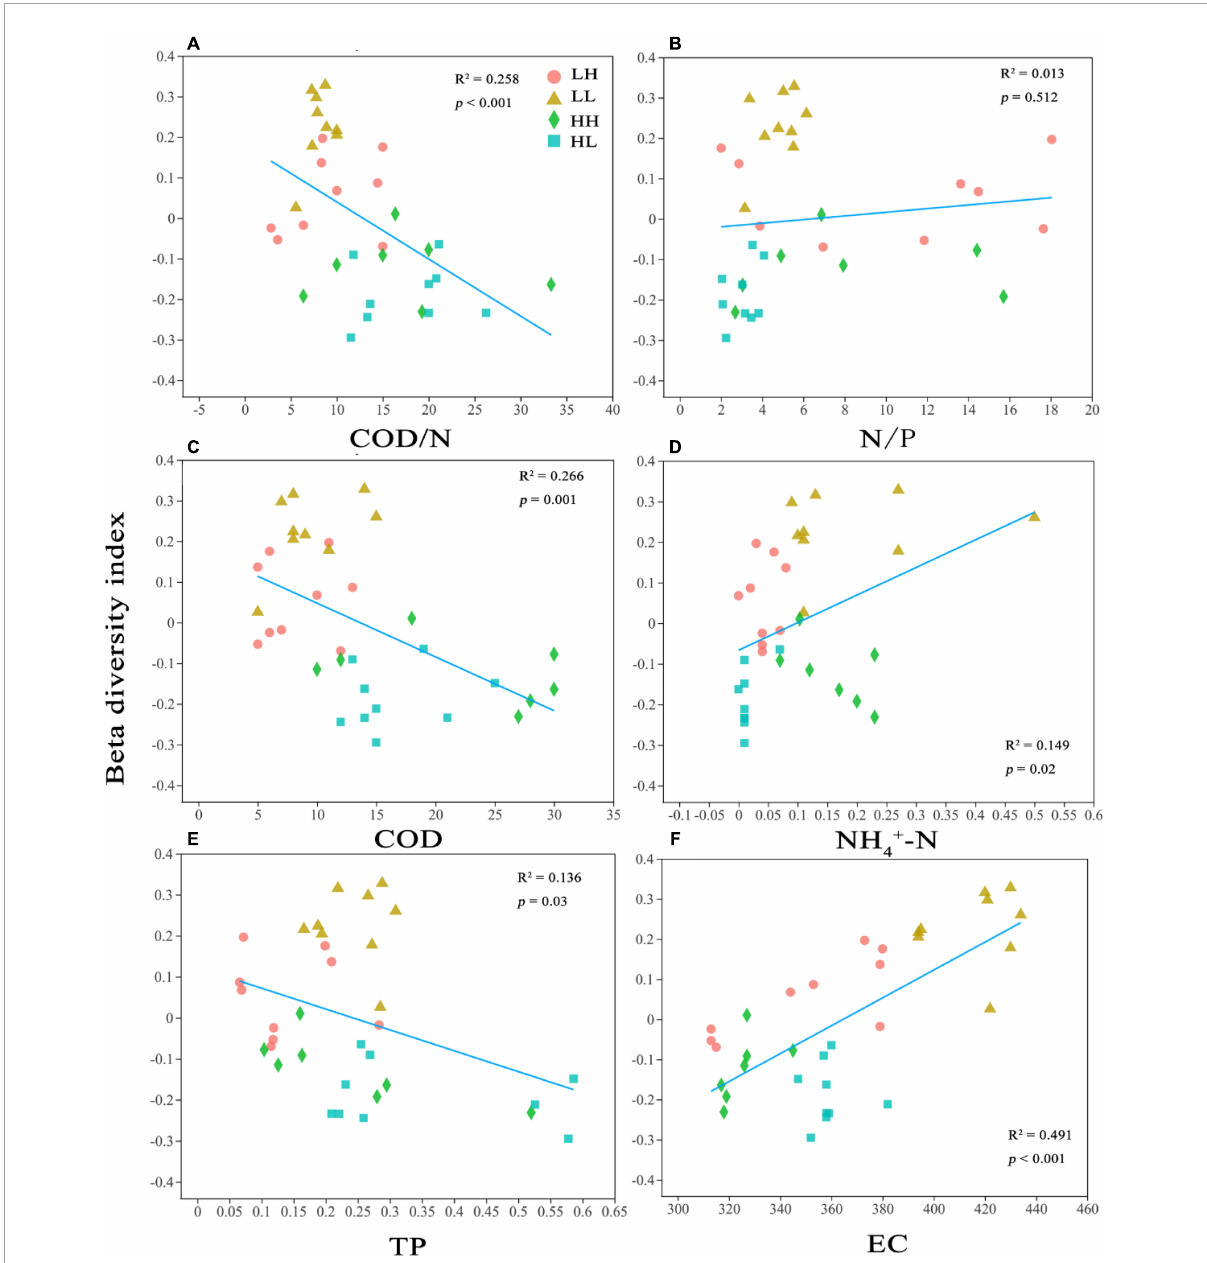
FIGURE4 Relationships between bacterial beta diversity and (A) Chemical oxygen demand to nitrogen (COD/N), (B) nitrogen to phosphorus (N/P), (C) Chemical oxygen demand (COD), (D) ammonia nitrogen (NH 4 + -N), (E) total P (TP), and (F) electrical conductivity (EC). R 2 represents the correlation coefficient; p < 0.05 indicates significance and p > 0.05 indicates